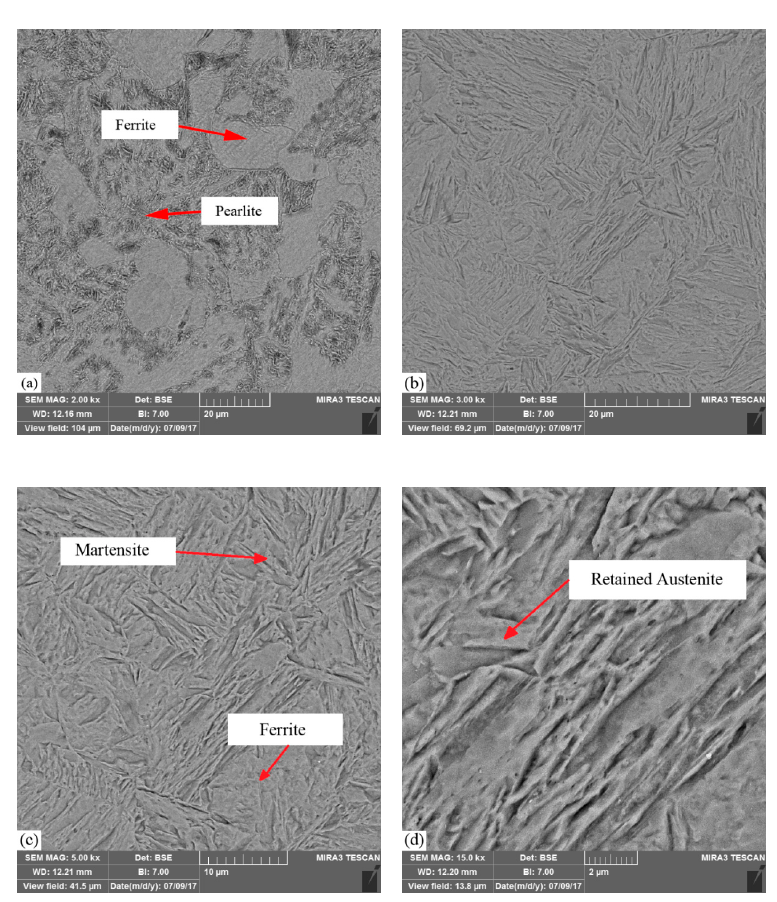
Figure 15. Field emission scanning electron microscopy (FESEM) images of the LH zone and base material of AISI 4130. ( a ) Base material 2 KX; ( b ) hardened zone 3 KX; ( c ) hardened zone 5 kx; ( d ) hardened zone 15 KX.